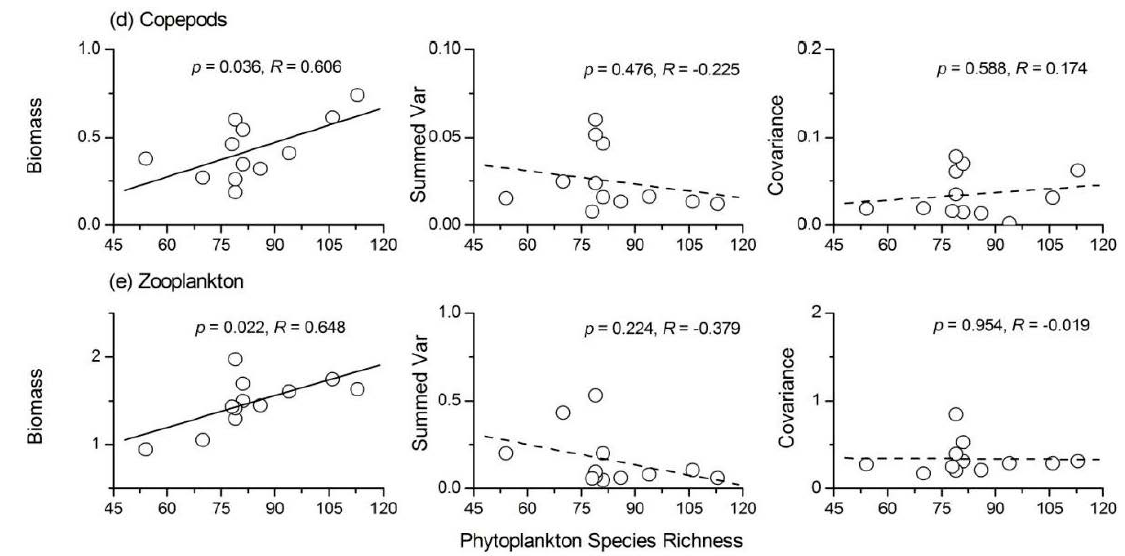
Figure 8. Relationships between phytoplankton species richness and the three components of community stability for ( a ) protozoa; ( b ) rotifer; ( c ) Cladocera; ( d ) copepods and ( e ) total zooplankton.